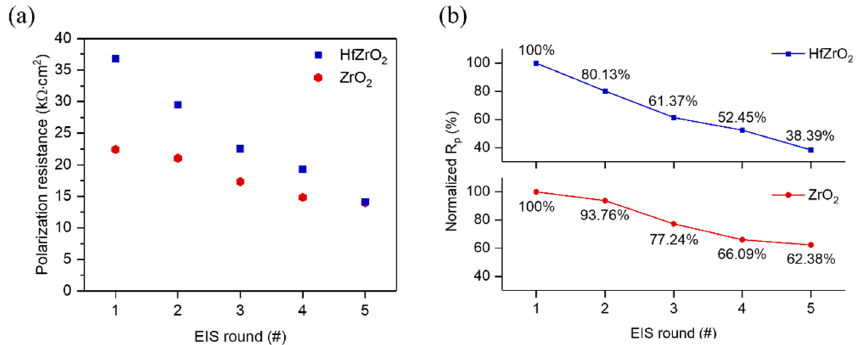
Figure 10. The decline of corrosion resistance of ZrO 2 and HZO films. ( a ) the absolute value of polarization resistance, and ( b ) normalized polarization resistance of each EIS measurement. The corrosion resistance measured in each round of EIS is normalized with the corrosion resistance of the 1 st round of EIS.